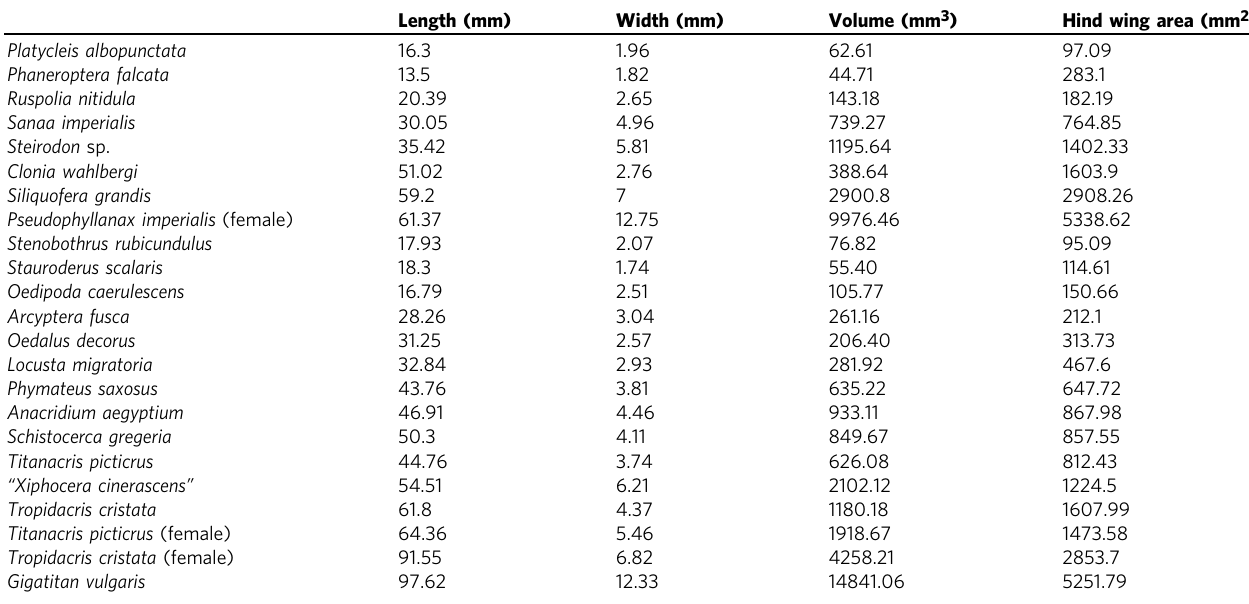
Table 1 Wing surface and body volume of extant fl ying Orthoptera and Gigatitan vulgaris . Without indication, used specimens were